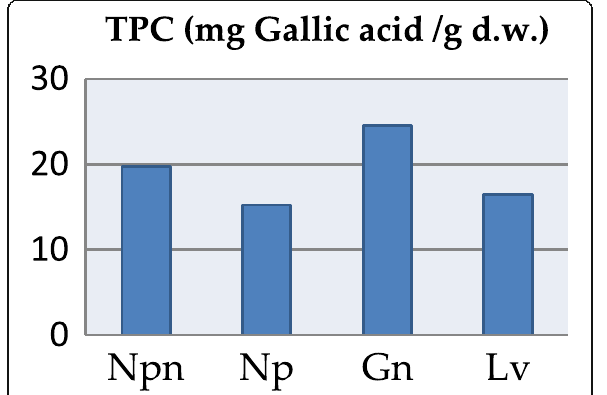
Fig. 5 Total phenol content (TPC) of Amaryllidaceae species